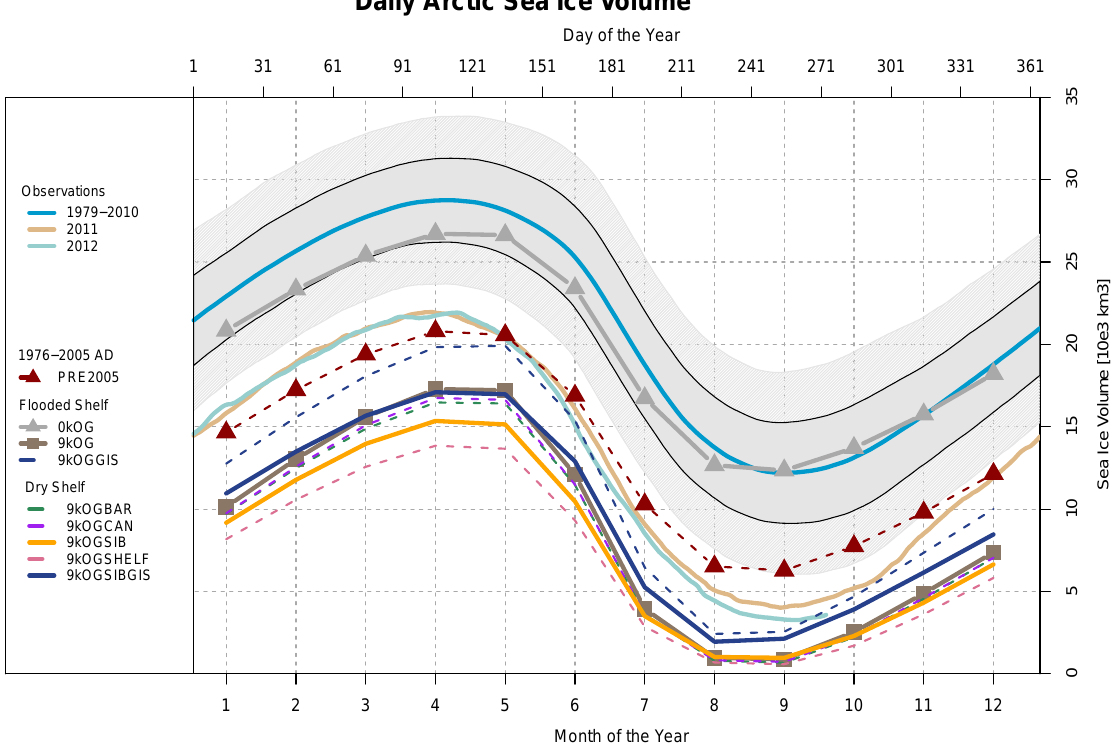
Fig. 2. Daily Arctic sea-ice volume from PIOMAS (Zhang and Rothrock, 2003) and monthly means for model experiments at 9kaBP and 0kaBP. Separated lines for most recent years 2011 and 2012. Grey areas denote one (two) standard deviations from 1979 to 2010 climatological mean. Please notice that LOVECLIM uses a fixed calendar with 360 days and the data embodies leap years. Model values are monthly means of the last 100yr of each simulation, except for simulation PRE2005 giving monthly means of the period 1976 to 2005 AD.